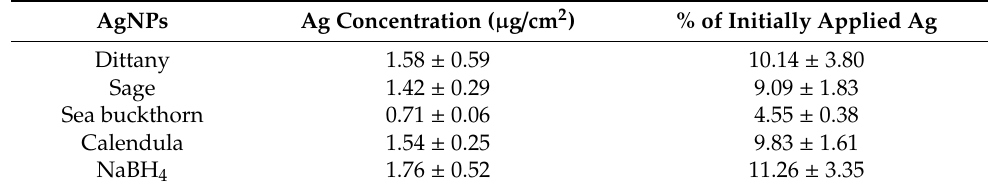
Table 4. Ag detected in the stratum